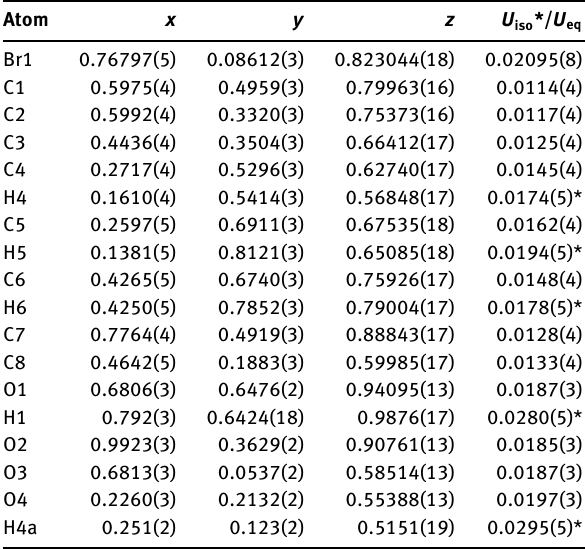
Table 2: Fractional atomic coordinates and isotropic or equivalent isotropic displacement parameters (Å 2